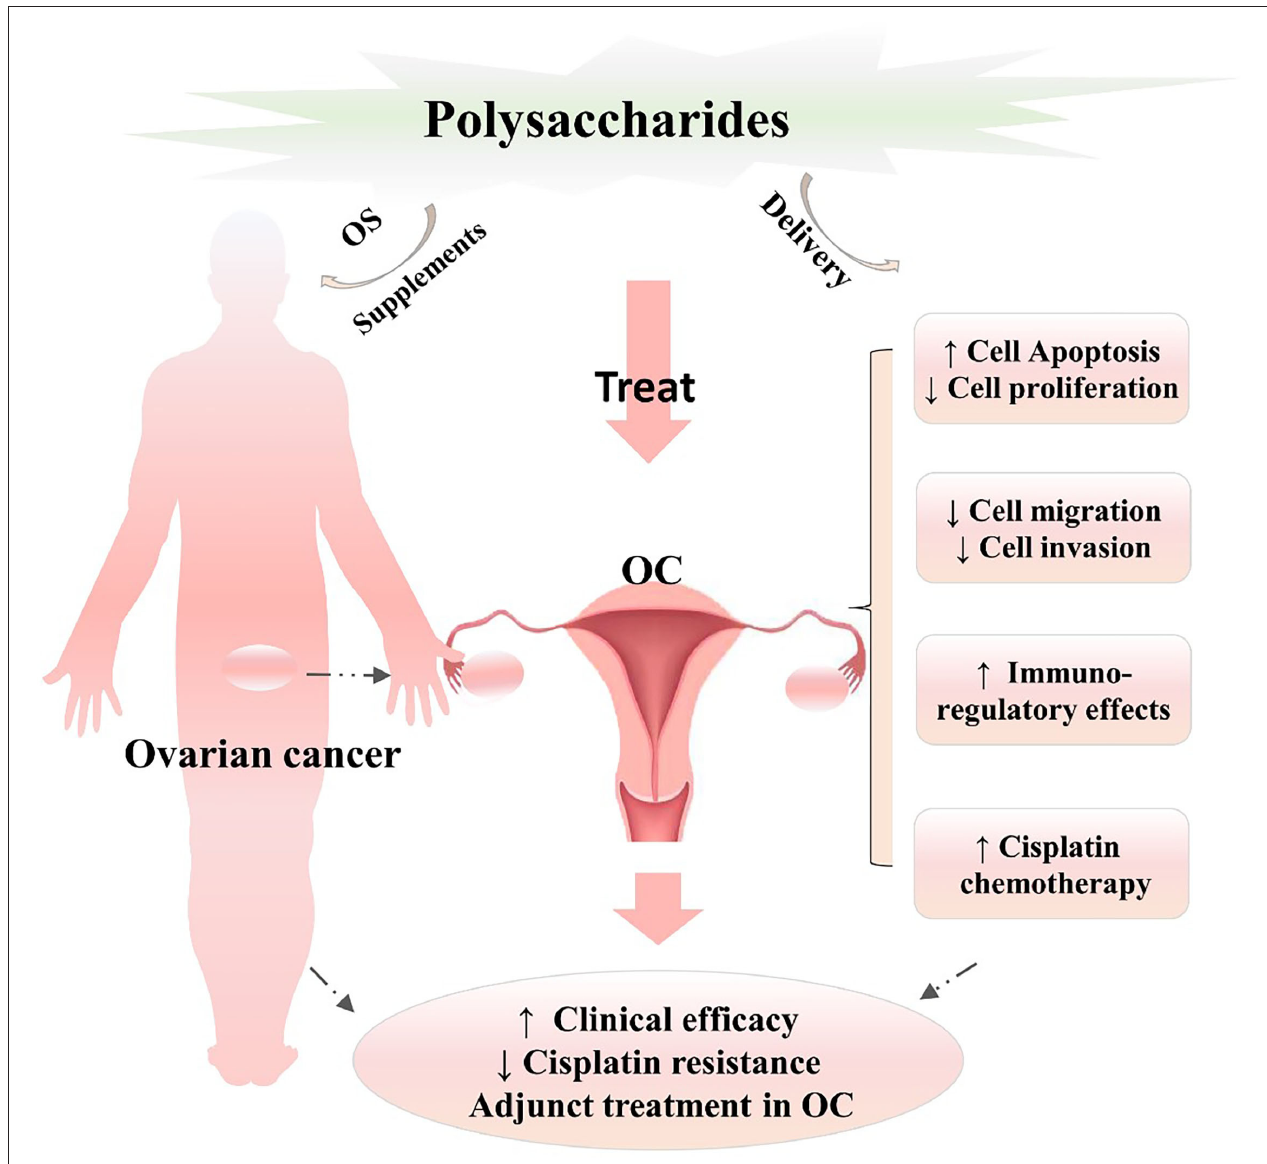
FIGURE 2 | Analysis of the therapeutic prospects of natural polysaccharides in the treatment of OC. Polysaccharides play vital roles in inhibiting cell proliferation and growth, regulating the tumor cell cycle, inducing cell apoptosis, suppressing tumor cell migration and invasion, improving immunomodulatory activities, and enhancing the efficacy of chemotherapy in OC and can be developed as adjunct agents or supplementary treatments in combination with cisplatin, which needs to further develop in the process of polysaccharide healthcare products in future work. OC, ovarian cancer; ↑ , significantly enhance or improve; ↓ significantly downregulate or